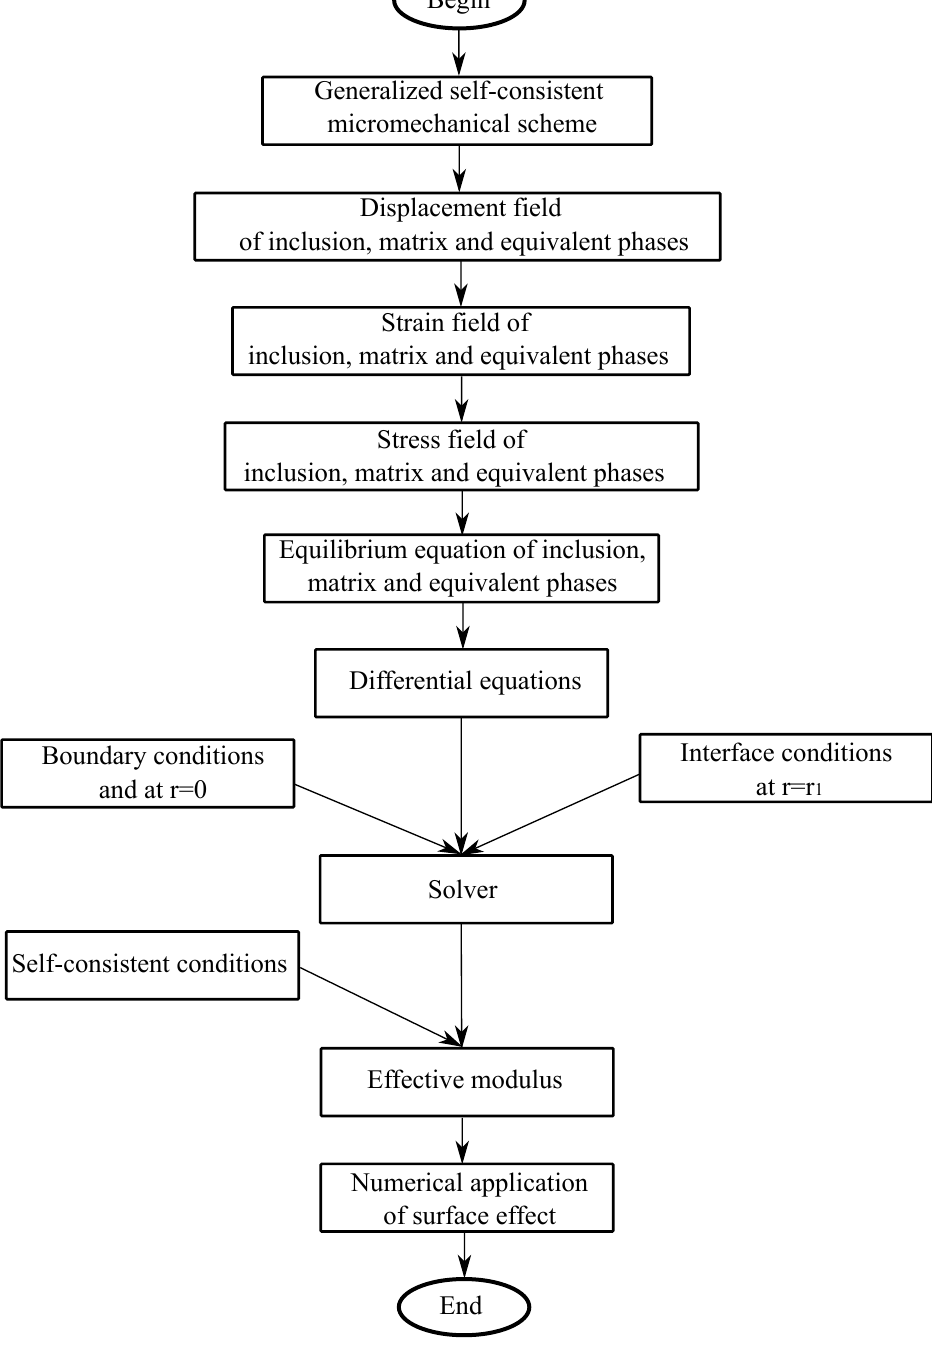
Figure 5. Flowchart of the proposed approach to determine the effective modulus of the heterogeneous